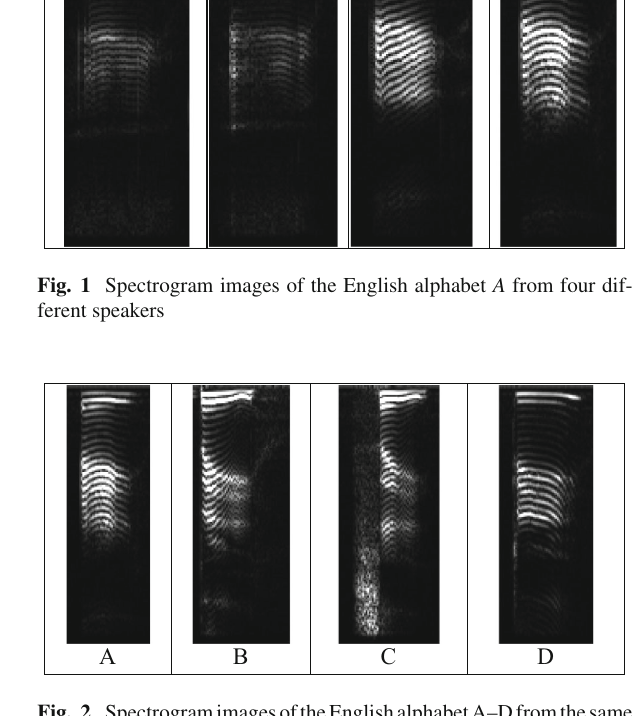
Fig. 2 SpectrogramimagesoftheEnglishalphabetA–Dfromthesame